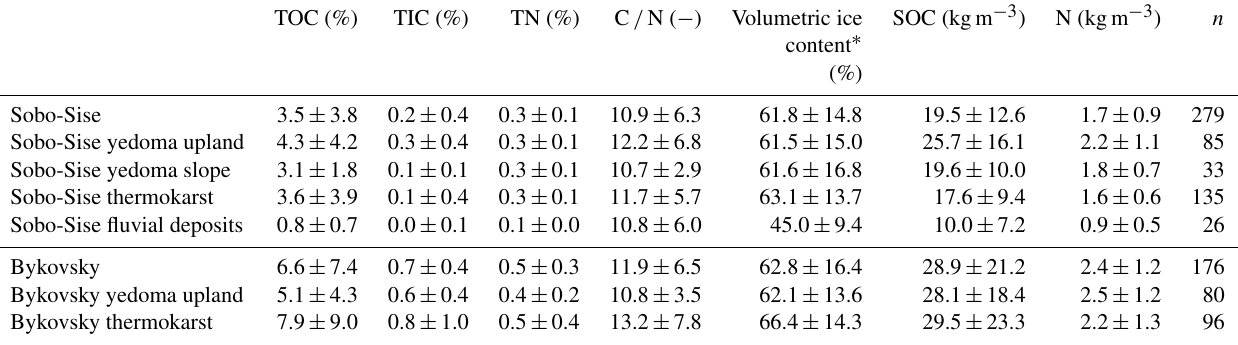
Table 1. Laboratory results of soil C, N, and ground ice characteristics for the different geomorphological landform units on Sobo-Sise Island and Bykovsky Peninsula. All values are mean values ± standard deviation. Median values for all parameters are provided in Table